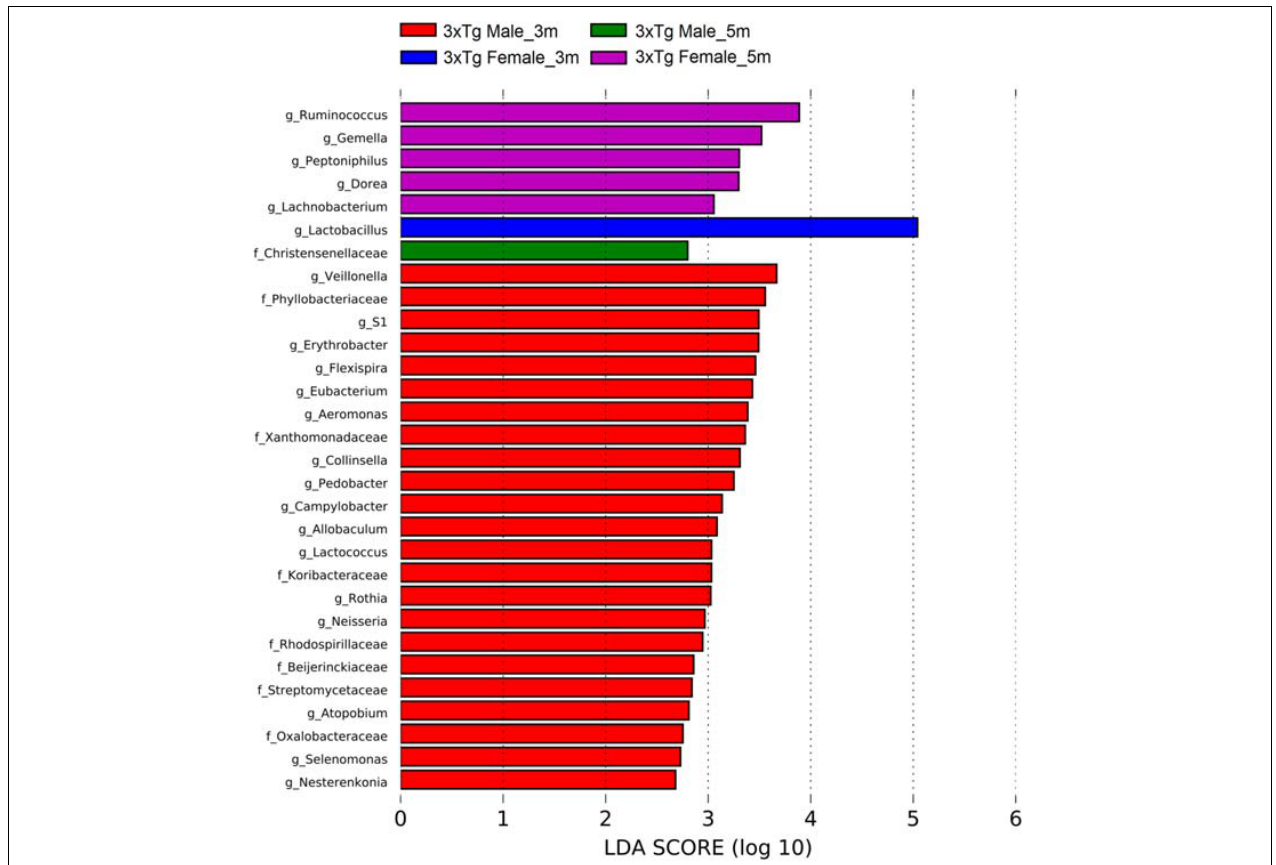
FIGURE 13 | Bacteria with statistically significant change on Alzheimer’s disease triple-transgenic (3xTg-AD) mice at 3 and 5 months (m) old in male and female in fecal samples. The bacteria with statistical relevance are shown by colors: red indicates 3xTg-AD male at 3 months old, green indicates 3xTg-AD male at 5 months old, blue indicates 3xTg-AD female at 3 months old, and pink indicates 3xTg-AD female at 5 months old. Horizontal bars represent the effect size for each taxon. The length of the bars represents the log10 transformed linear discriminant analysis (LDA) score, indicated by vertical dotted lines. The threshold on the logarithmic LDA score for discriminative features was set to 2.0. The name of bacteria with a statistically significant change in the relative abundance is written alongside the horizontal lines. Taxa names are abbreviated as “f,” family, and “g,” genus. See Supplementary Table 7 for full taxon description and LDA score and p